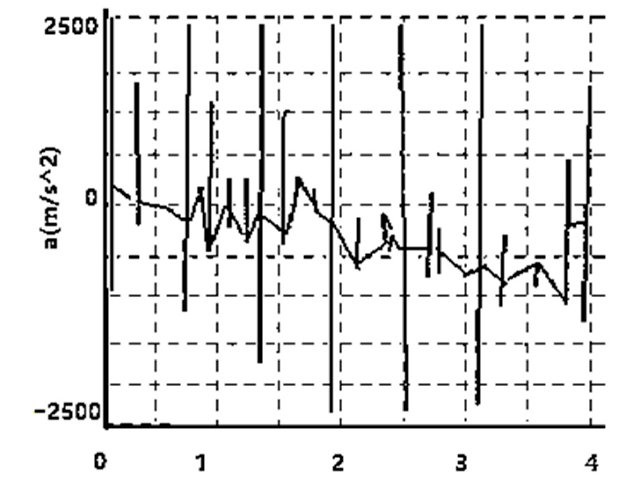
Figure 25. The amplified longitude acceleration of Figure 19.